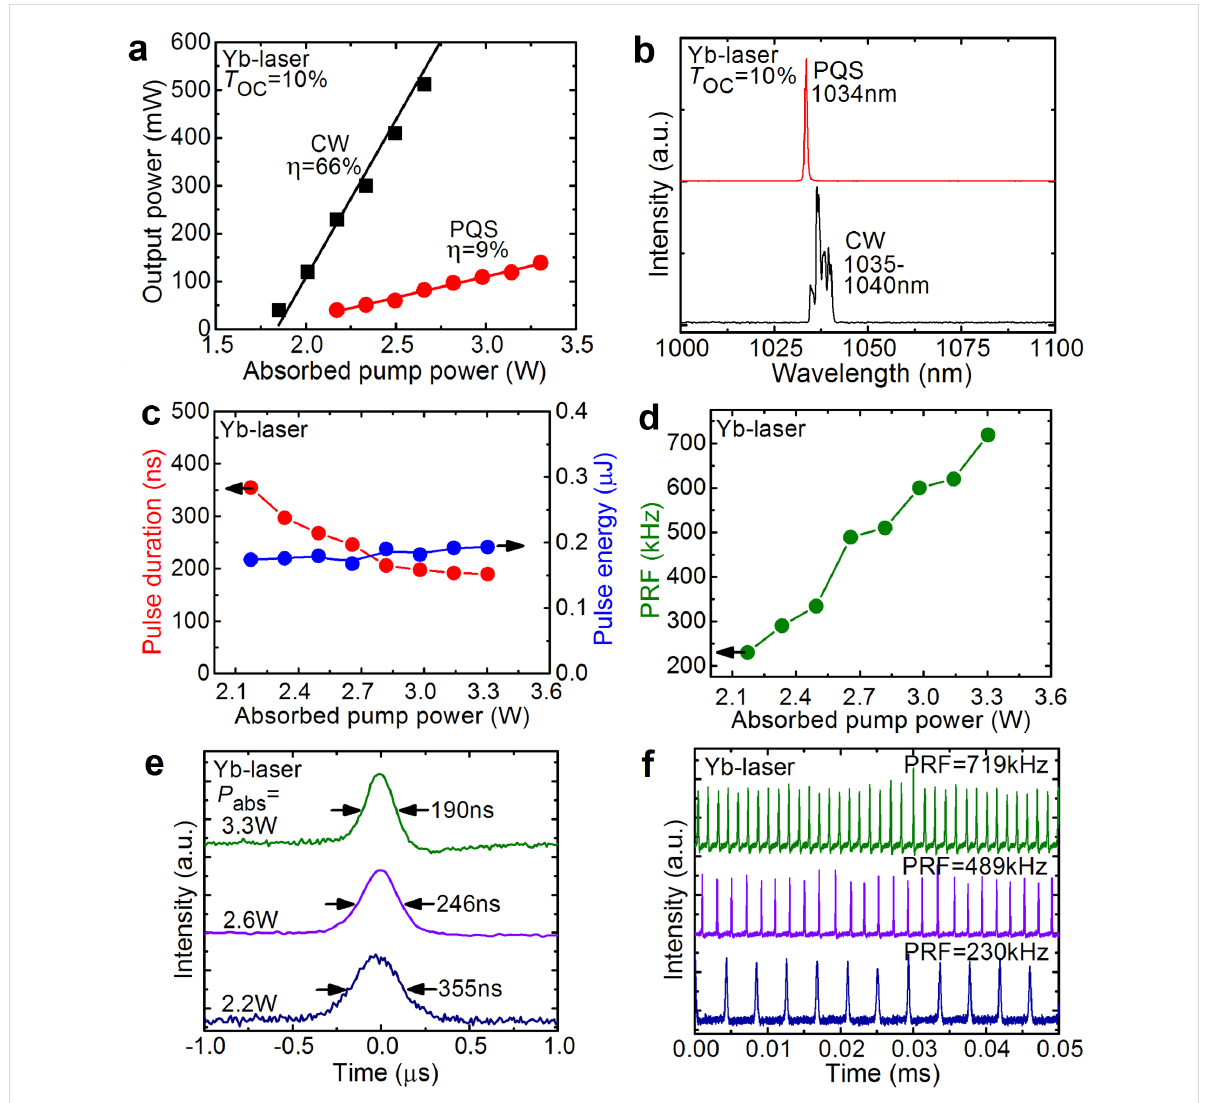
Figure 6: Yb:KLuW laser: CW operation and passive Q-switching by ZnO nanorods grown for 5 h: (a) input–output dependences, η – slope efficiency (the data for PQS operation are adapted from [28]); (b) typical laser emission spectra measured at the maximum P abs ; (c) pulse duration and pulse energy; (d) pulse repetition frequency (PRF); (e,f) typical oscilloscope traces: (e) single Q-switched pulses and (f) the corresponding pulse trains for various P abs (the pulse train corresponding to a PRF of 719 kHz is adapted from